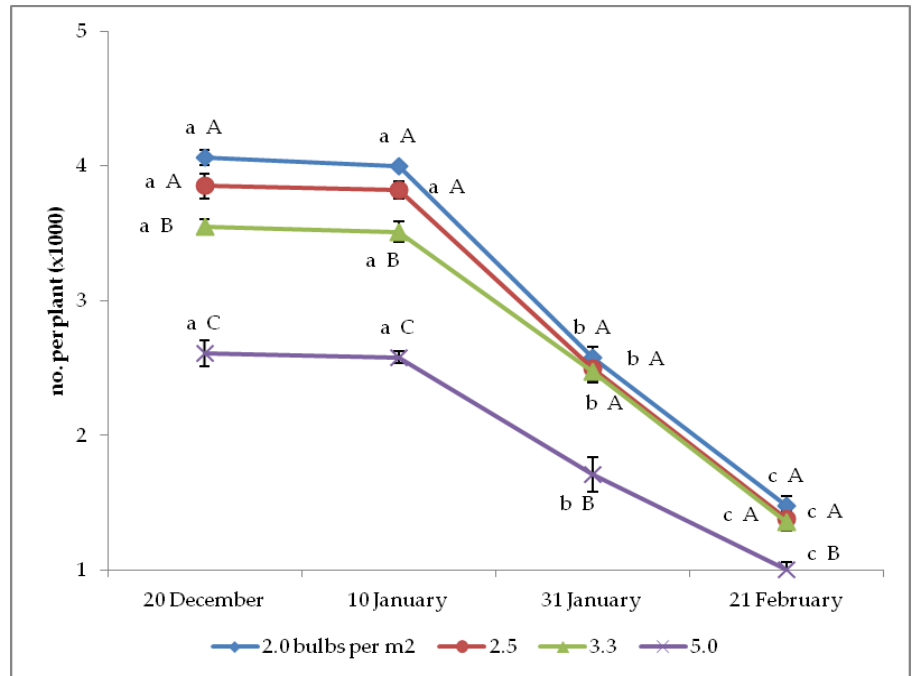
Figure 3. Interaction between bulb planting time and density on onion seed number per plant ( n = 3). Different letters mean significant difference in the comparison between planting times (lowercase letters) or between bulb densities (capital letters), according to the Duncan test at p ≤ 0.05. Standard deviation bars are shown per each value.